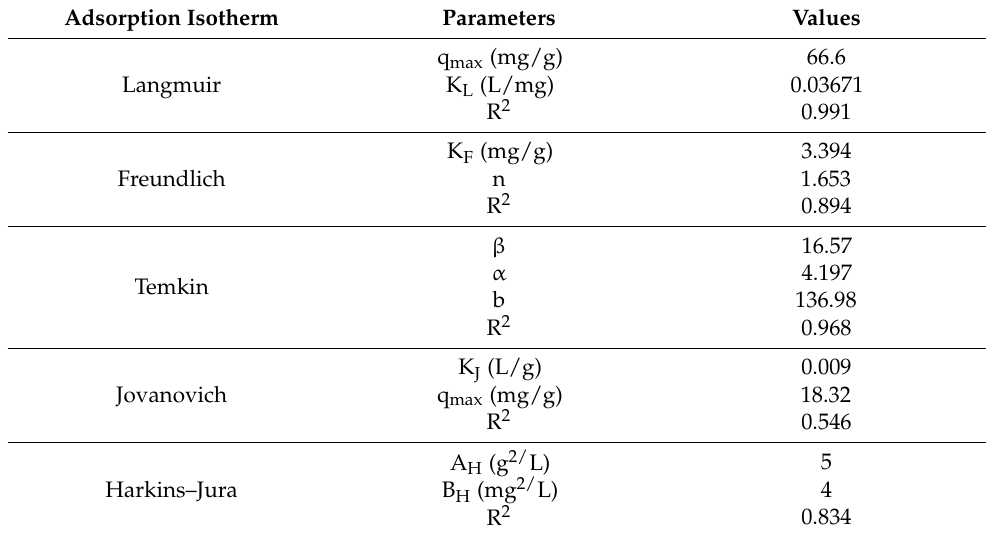
Table 2. Isothermal parameters for adsorption of Cr (VI) on CMPVL. Adsorption